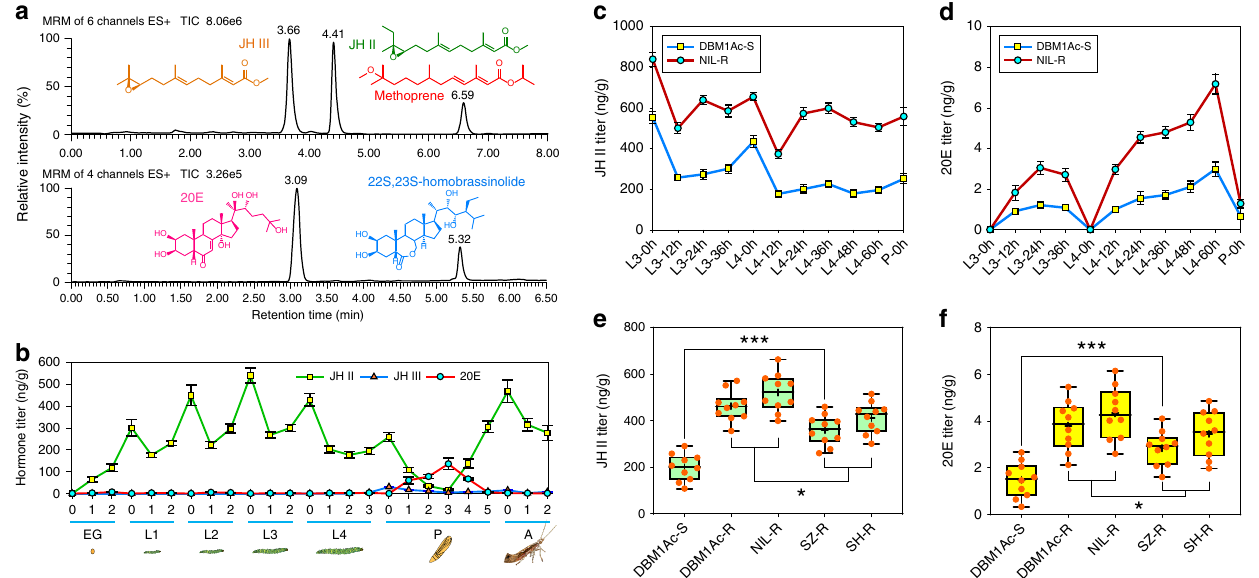
Fig. 5 Detection of hormone titers in susceptible and resistant P. xylostella . a Representative MRM chromatograms of the standard solutions of JHs (JH II and JH III, 5 ng), 20E (2 ng), methoprene (0.1 ng), and 22S, 23S-homobrassinolide (0.1 ng) detected by UPLC – MS/MS. b Hormone titers in whole developmental stages of the DBM1Ac-S strain. EG: eggs; L1-4: fi rst- to fourth-instar larvae; P: pupae; A: adults. Samples were collected daily in each stage for hormone titer detection. JH II ( c ) and 20E ( d ) titers from third- to fourth-instar larvae of both DBM1Ac-S and NIL-R strains. Samples were collected every 12 h in both stages for accurate detection of hormone titer changes. e , f Box plots show JH II ( e ) and 20E ( f ) titers in all of the susceptible and resistant P. xylostella strains. Each orange dot represents mean hormone titer in two 1-day-old fourth-instar larvae and the black plus sign indicates mean hormone titer of all the detected individuals in each strain. Median and quartile values are provided by the central line and box boundaries, whiskers show min to max values. Data are presented as mean values ± SEM, n = 3 ( b – d ) and n = 10 ( e , f ) biologically independent samples, * p < 0.05, *** p < 0.001, one- way ANOVA with Holm – Sidak ’ s test was used in ( e ) and ( f ) for comparison. Source data are provided as a Source Data fi le.